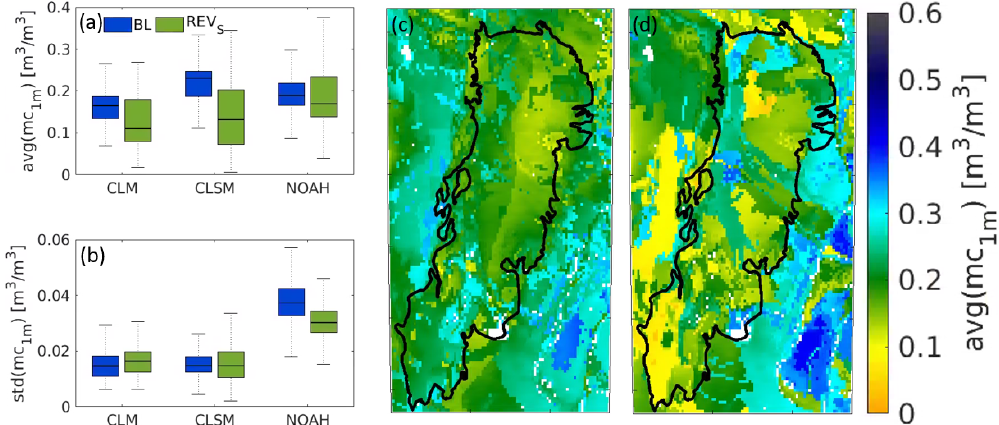
Figure 4. Boxplots of long-term (1992–2015) (a) average (avg) and (b) standard deviation (SD) of BL and REV S moisture content in the upper 1m (mc 1m ) for CLM, CLSM and NOAH. Maps of long-term (1992–2015) average NOAH mc 1m , obtained with (c) BL and (d) REV S parameters.